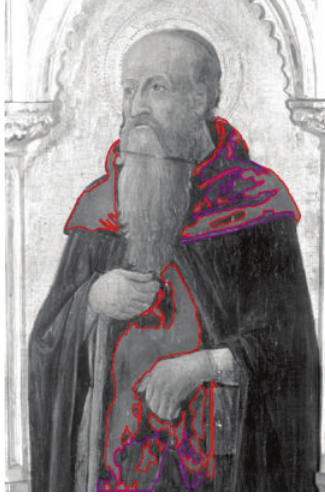
Figure 2: Visible RGB of Figure 1. Figure 4: PC2 result with additional information and features provided with respect to the visible spectrum indicated with red and purple colour and to IR2 band, with orange colour, as well.